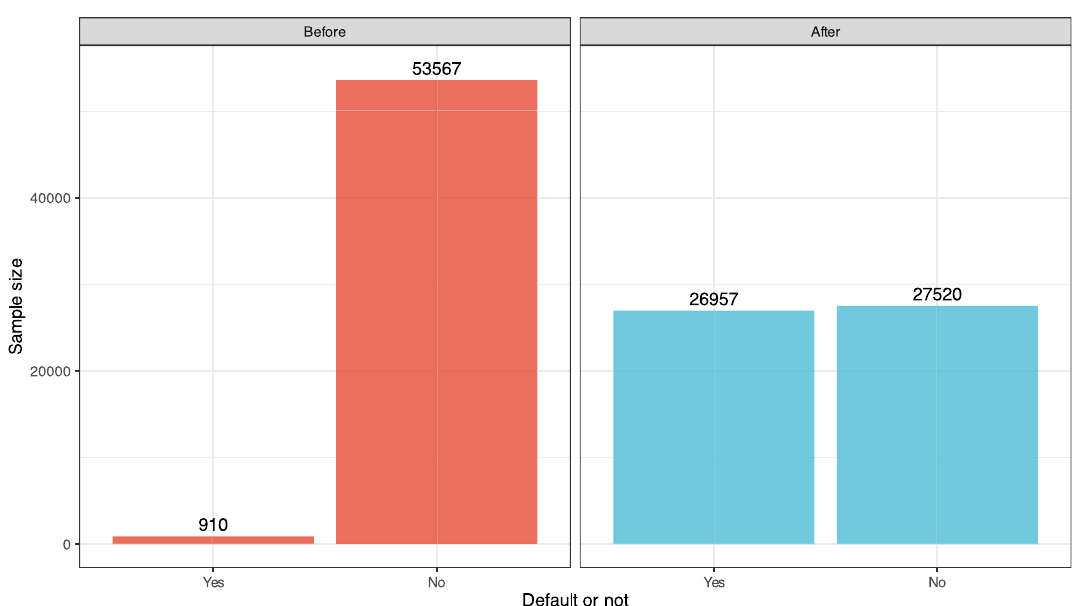
Figure 1. Transformation of an imbalanced dataset into a balanced dataset by using